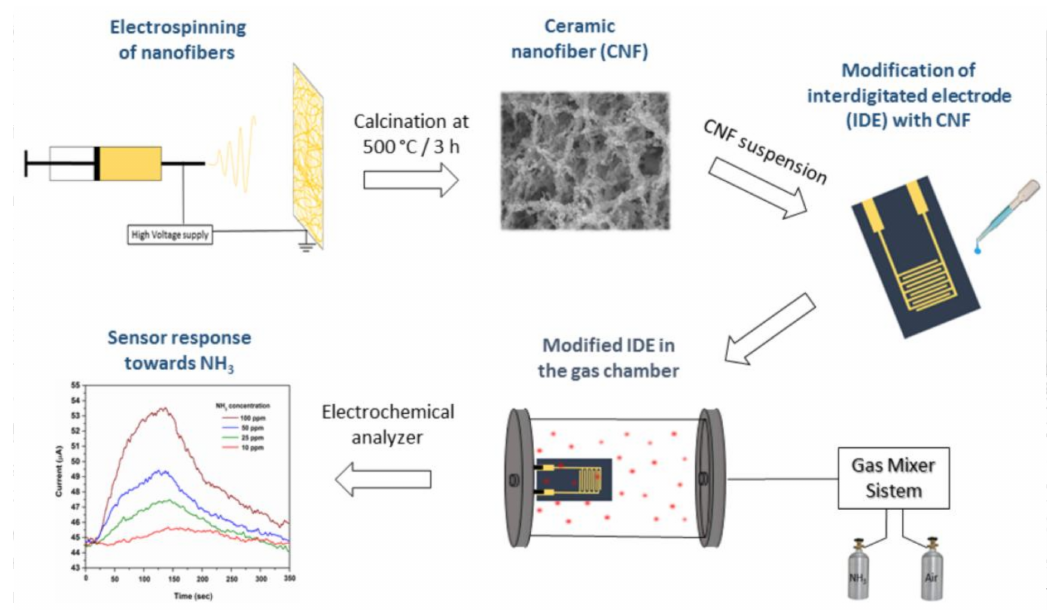
Figure 1. Schematic representation of the ceramic nanofibers (CNF) fabrication deposited onto gold interdigitated electrode (IDE) and the system for NH 3 monitoring